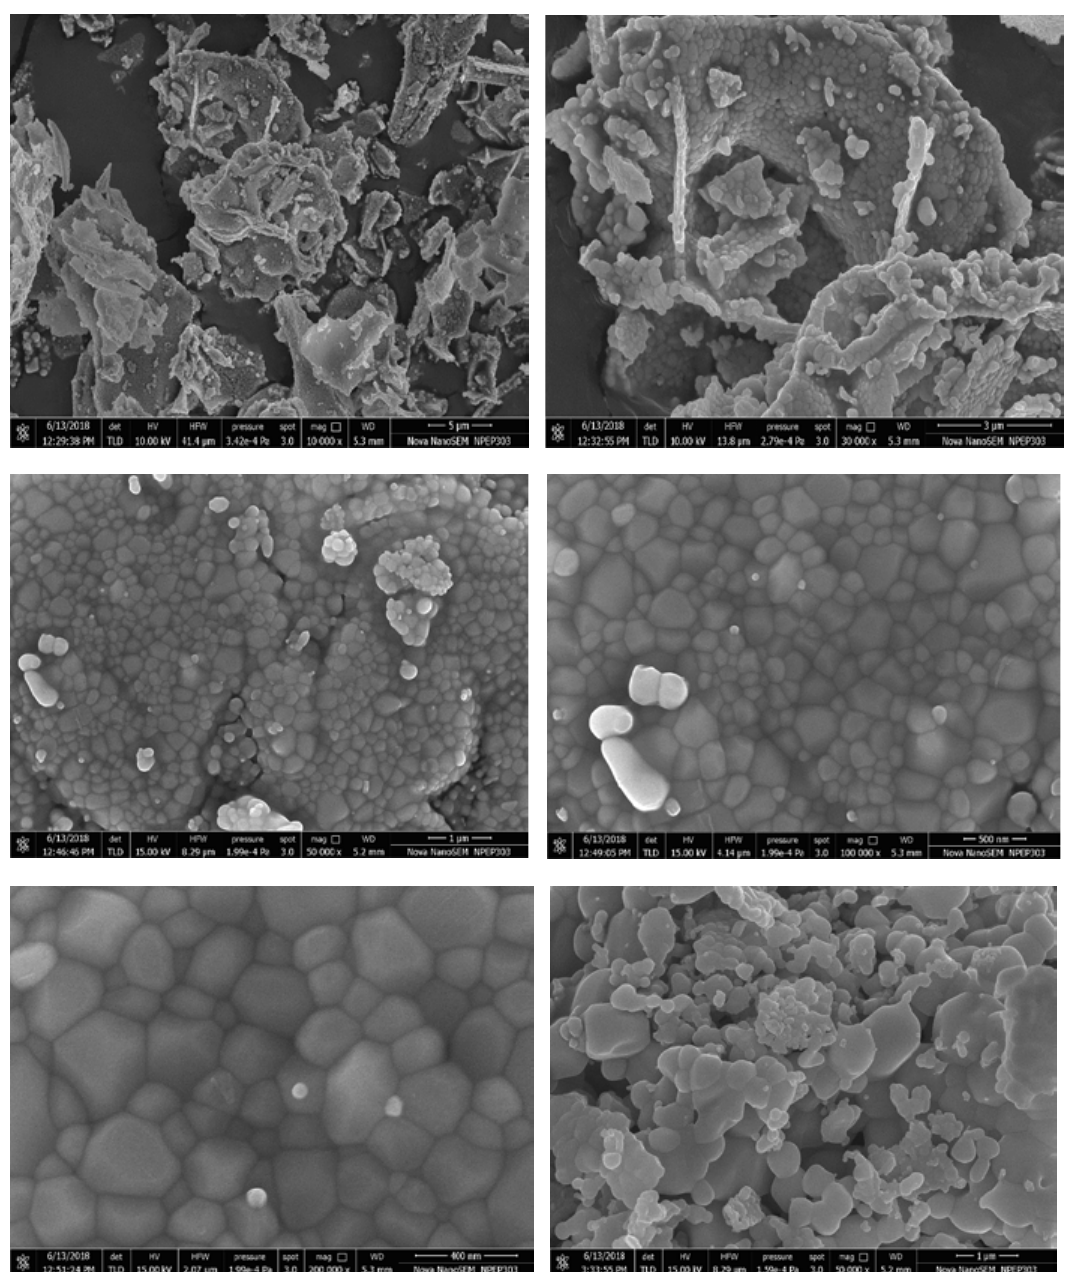
Fig. 3. FESEM images of the synthesized CeVO